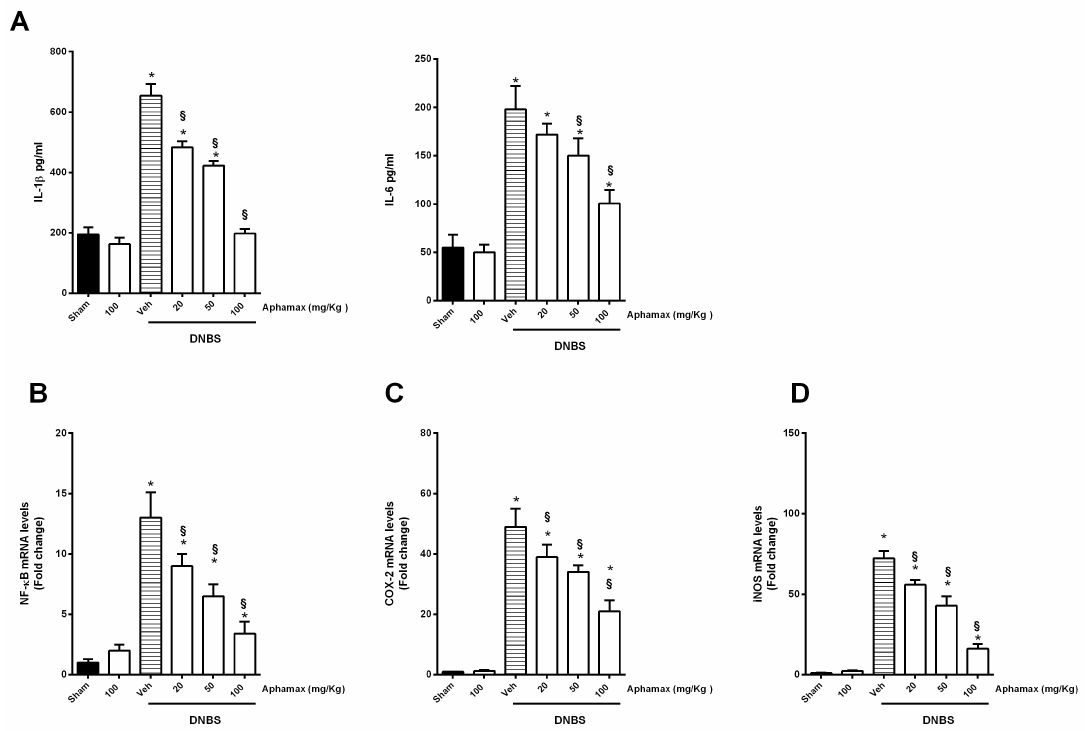
Figure 3. Effects of Aphamax ® on pro-inflammatory mediator levels ( A ) Levels of IL-1 β , IL-6 levels; ( B ) NF-kB, ( C ) COX-2 and ( D ) iNOS mRNA expression. Data are means ± S.E.M. n = 5 animals for each group. * p < 0.05 versus Sham group; § p < 0.05 versus 2,4 dinitrobenzensulfonic acid (DNBS) group.